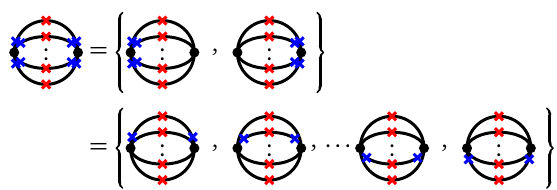
associated to the G